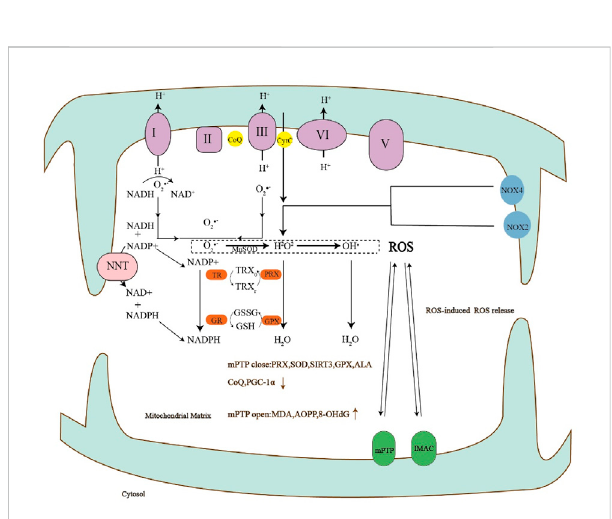
FIGURE 4 The production of reactive oxygen species can lead to the opening of mPTP, the opening of mPTP can increase the markers of oxidative stress, and the close of mPTP can lead to the decrease of